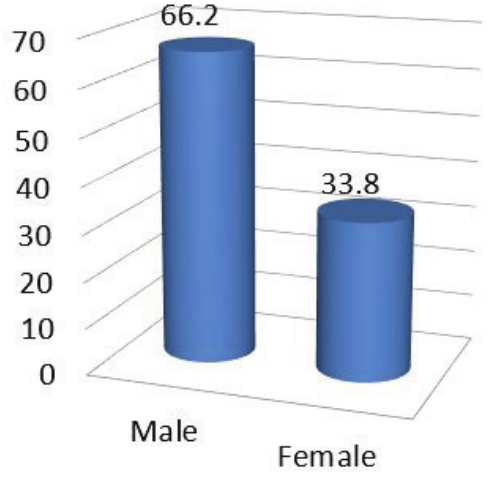
Figure 1: male to female proportion